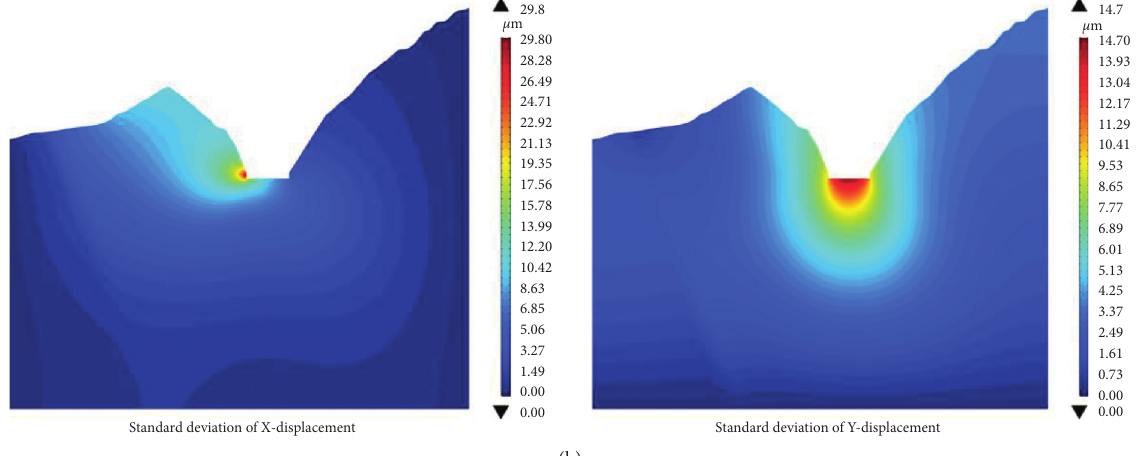
Figure 9: The standard deviation of